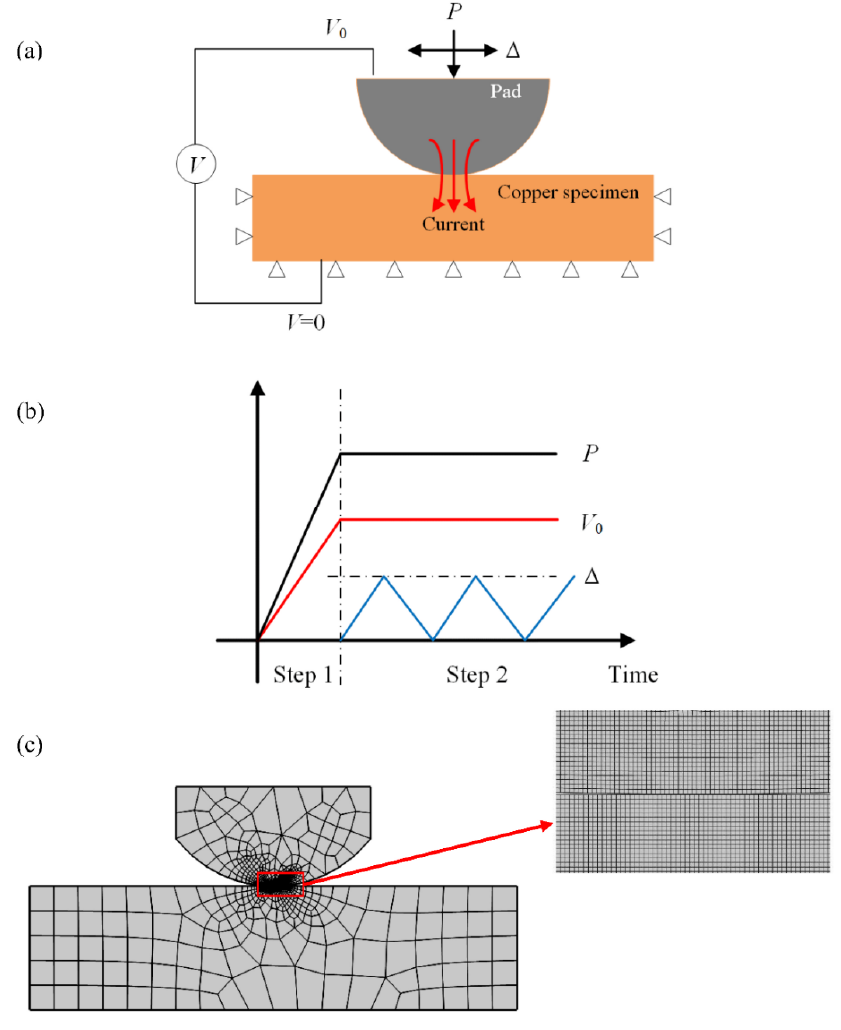
Figure 3. ( a ) Schematic of electrical contact, ( b ) histories of applied loads, and ( c ) finite element mesh of electrical contact.